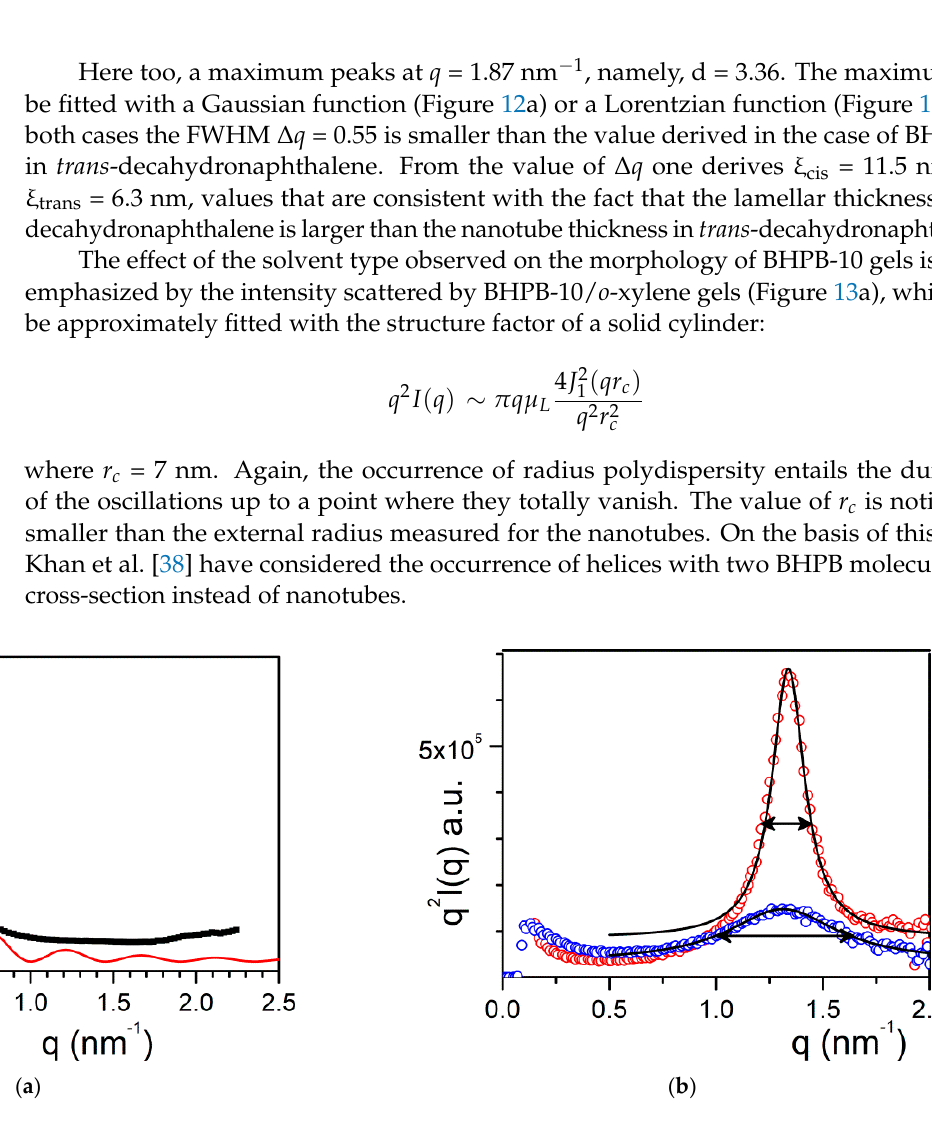
( b ) Figure 14. ( a ) Neutron Scattering patterns plotted by means of q 4 I(q) vs. q for propargyl ammonium-based molecule/D 2 O; C= 0.015 g/cm 3 ; regime 1 is a fit with relation 23 while regime 2 is the Porod regime. Inset magnification of regime 1; blue line is a fit of the peak with Equation (16). ( b ) arrangement of the molecules in a chevron-like fashion along the length of the lath [34].